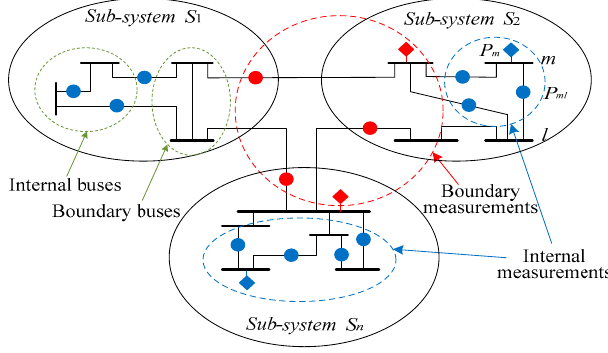
Figure 1. Partition of power systems.